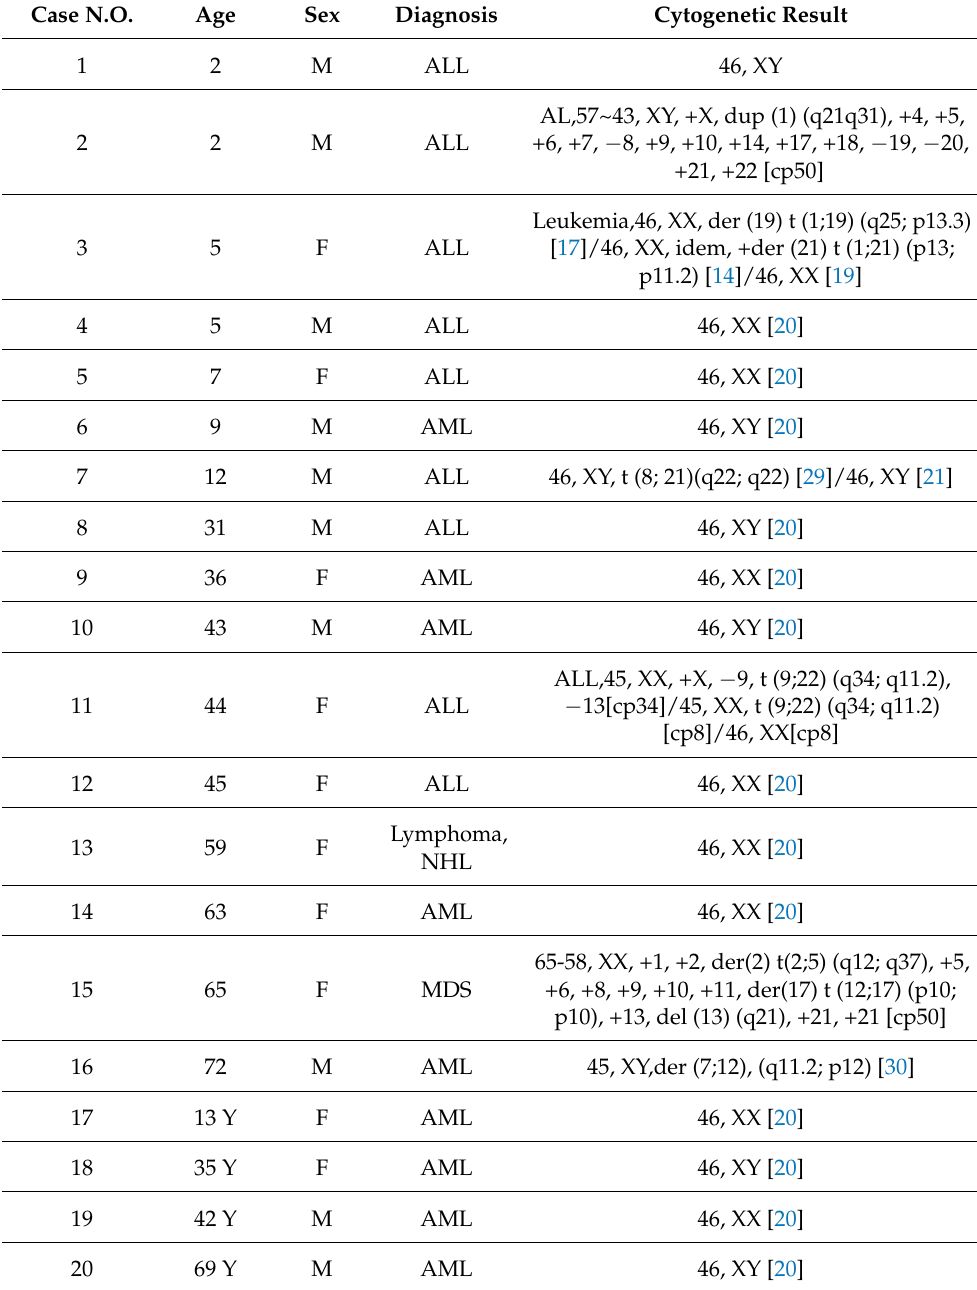
Table 2. Patient information and cytogenetic result. Case